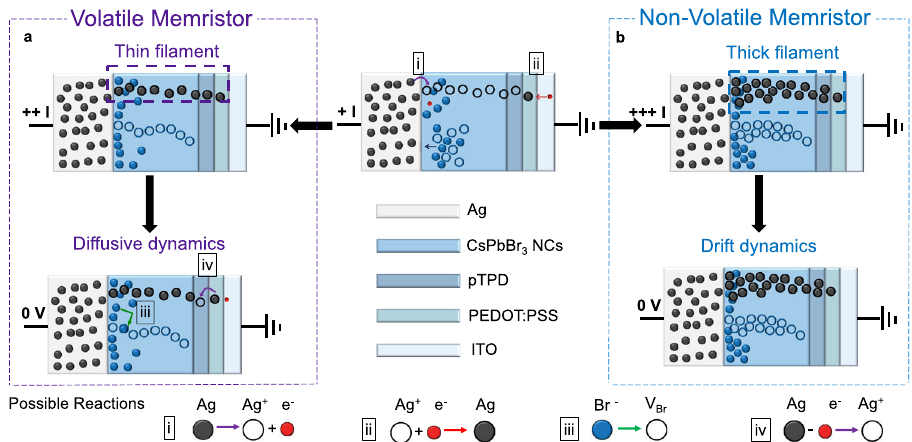
Fig. 2 Recon fi gurable halide perovskite memristor. The device structure comprises ITO (100 nm), PEDOT:PSS (30 nm), polyTPD (20 nm), OGB-capped CsPbBr 3 NCs (20 nm) and Ag (150 nm). a Diffusive mode- illustration of the proposed volatile diffusive switching mechanism. b Drift mode- illustration